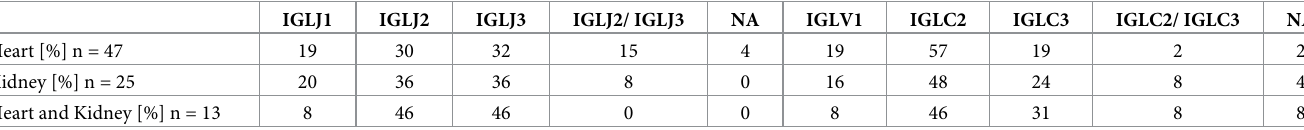
Table 3. Comparison of the usage of the IGLJ and IGLC